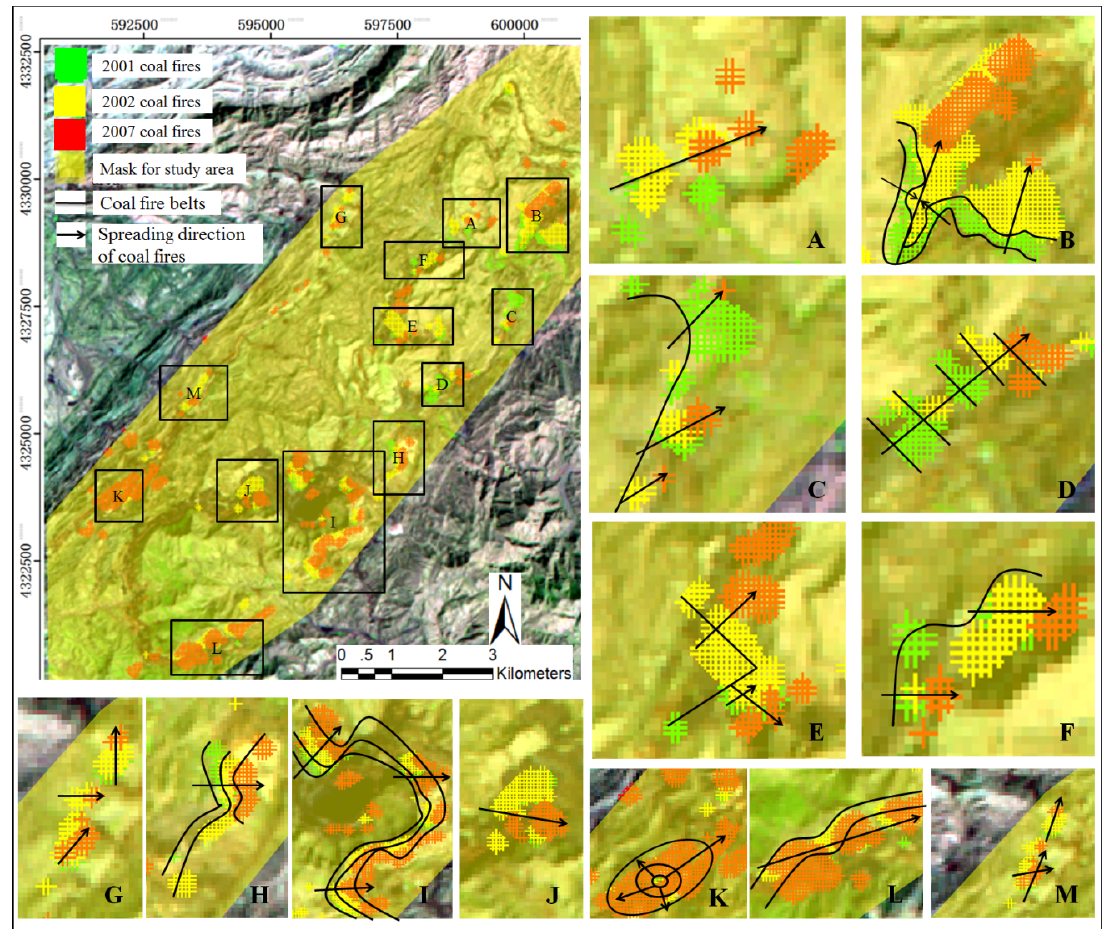
Figure 9. Delineation and prediction of spreading direction of coal fires based on the results of surface coal fires and the subsurface coal fires respectively extracted from the Landsat ETM+ SWIR band 7 data and the thermal band 6